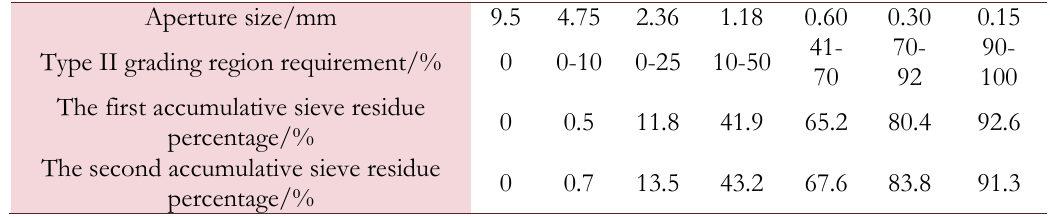
Table 1: Natural sand grain grading.